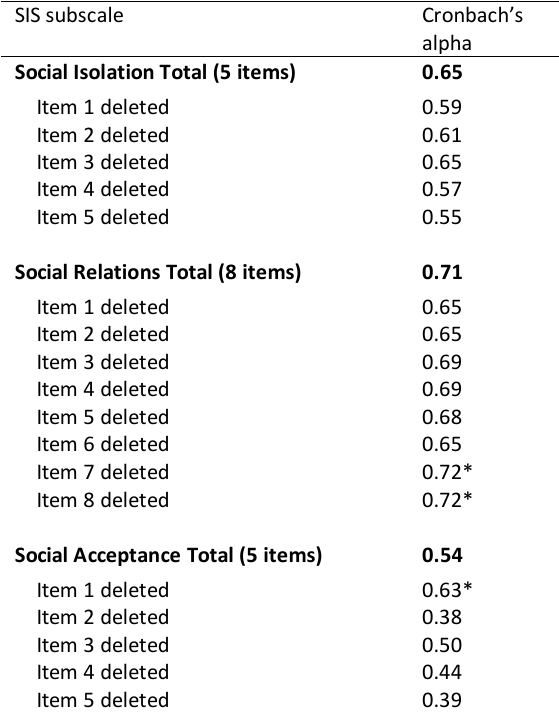
Table 3. Cronbach’s alpha using “scale if item